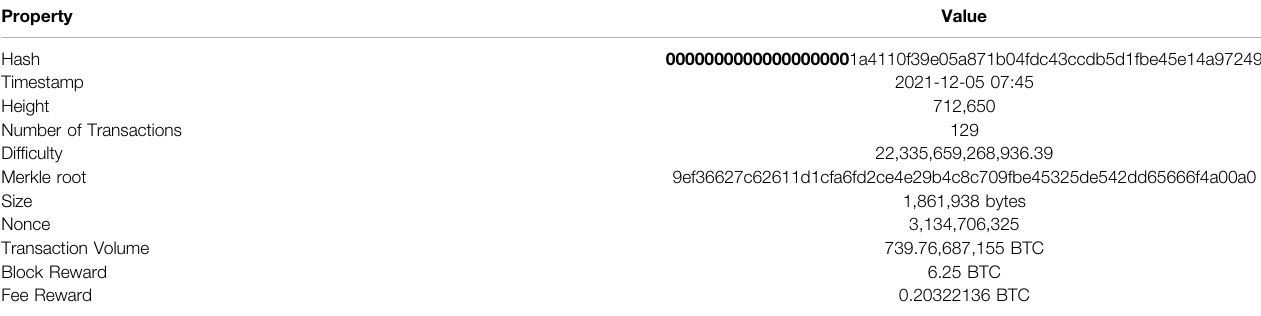
TABLE 2 | Details of Block 712,650 of the Bitcoin